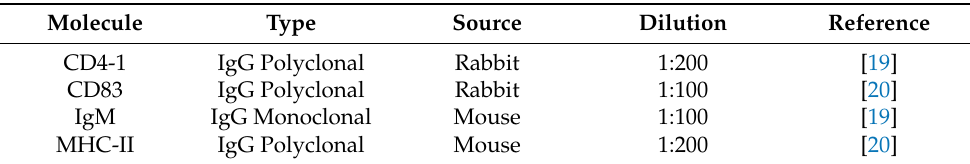
Table 1. Primary antibodies used in IFAT and